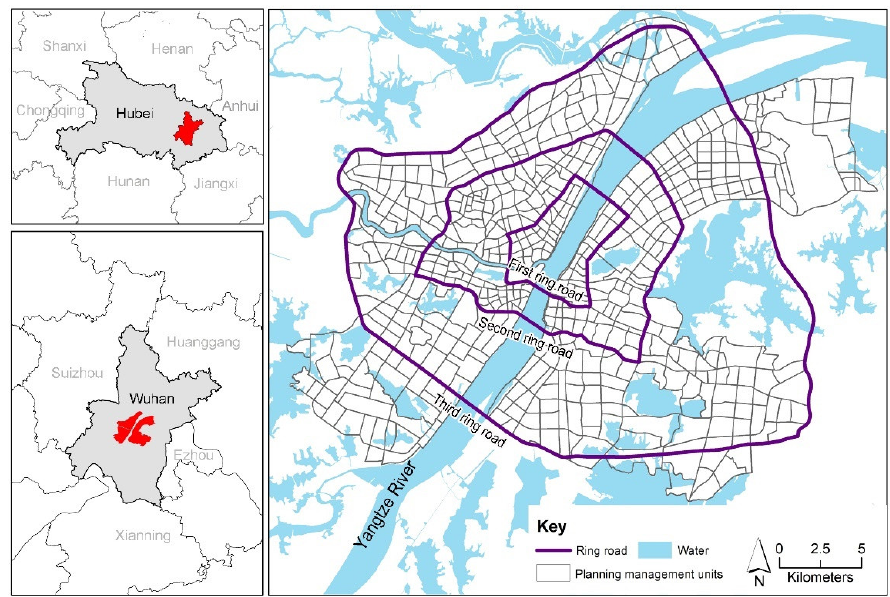
Figure 1. Location of Wuhan city and the study area.